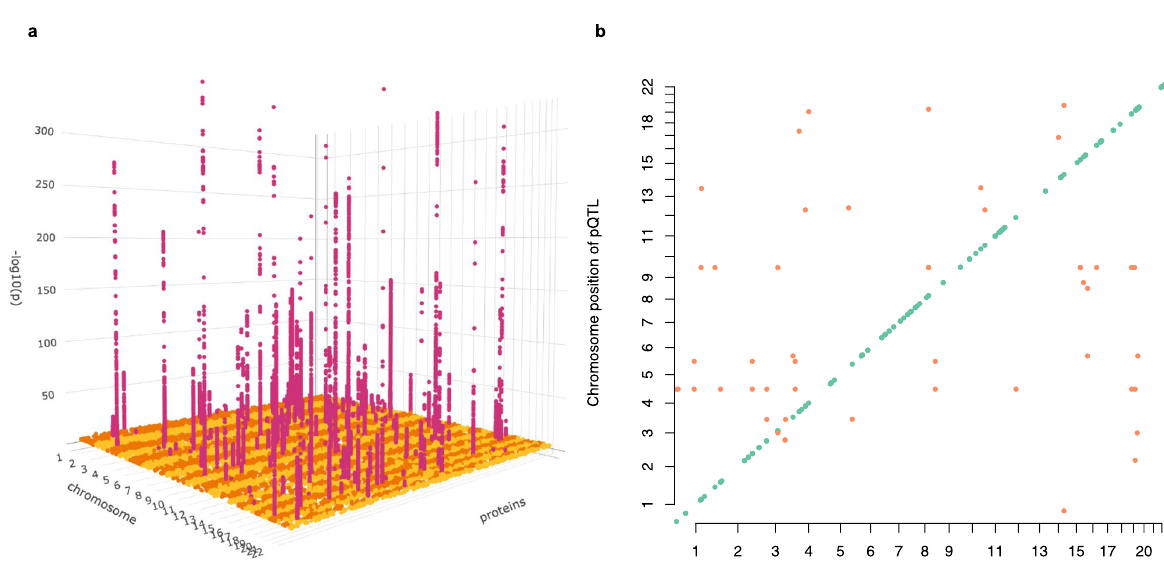
Fig. 1 pQTL signals for 107 serum proteins from Olink neurology and neuro-exploratory panels. a 3D Manhattan plot of detected pQTLs. The x axis represents each of the 107 proteins; the y axis represents the chromosome location of each signal; and the z axis represents the − log10 p -values of each association signal. b Scatterplot of pQTL variant location against the location of the gene encoding the target protein. Each dot represents an independent variant. Cis -pQTLs are coloured in teal, while trans -pQTLs are in orange.